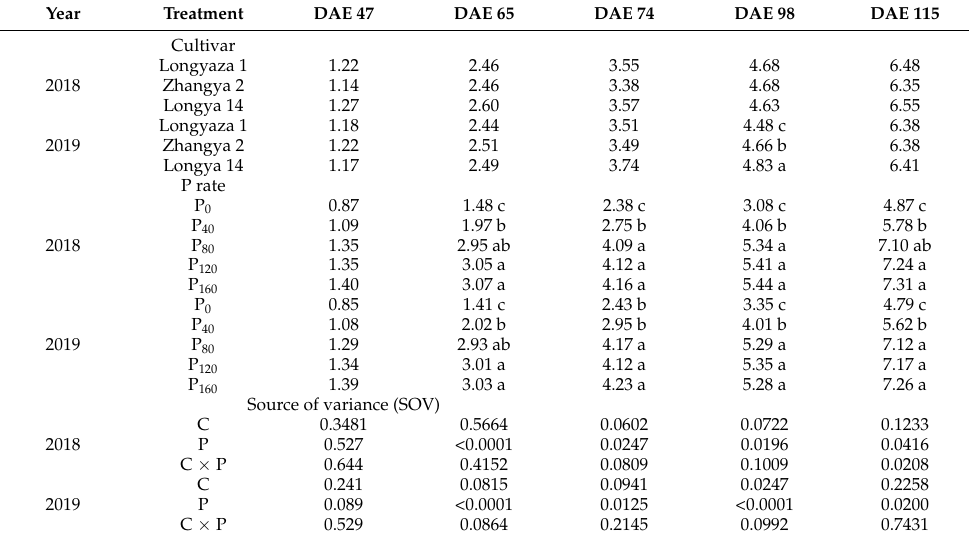
Table 2. Shoot biomass (t ha − 1 ) at Yongdeng in 2018 and 2019 with three cultivars flax and five phosphorus